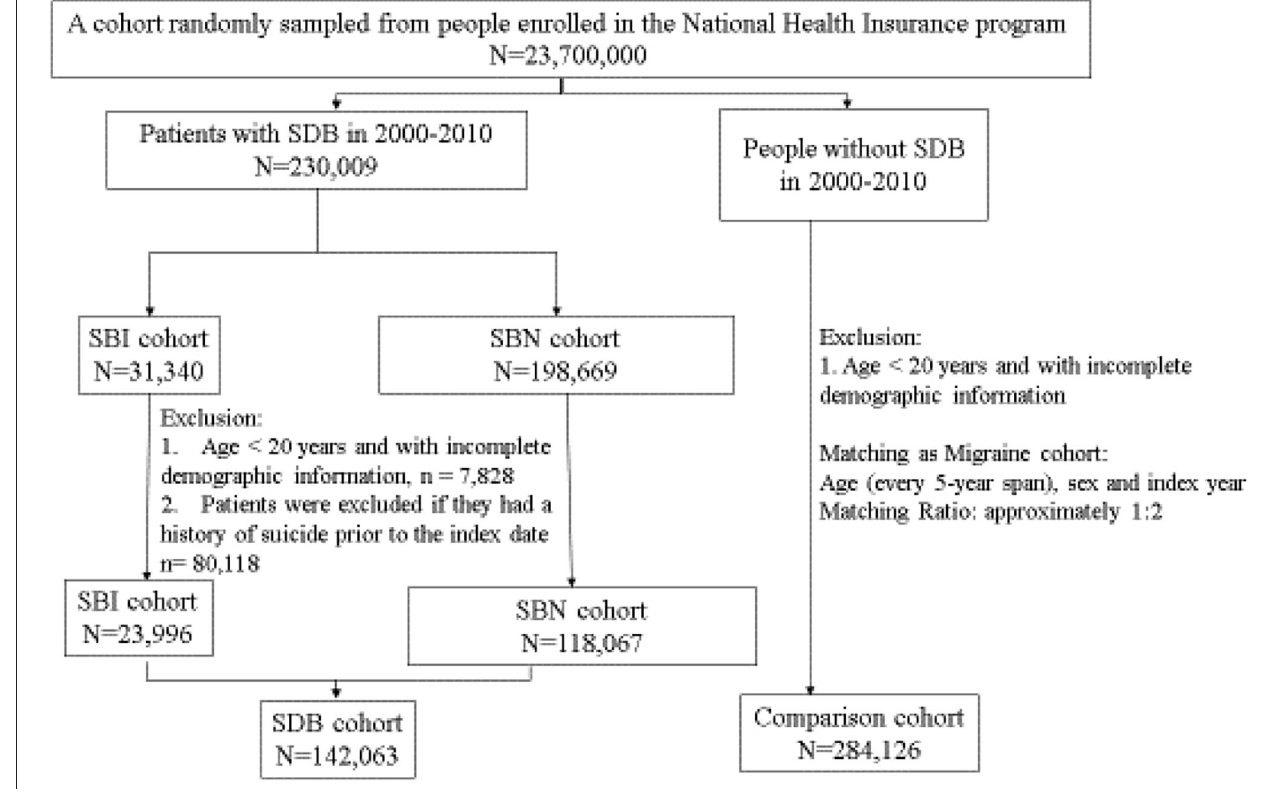
FIGURE 1 | The flowchart of the study population selected from the national health insurance research